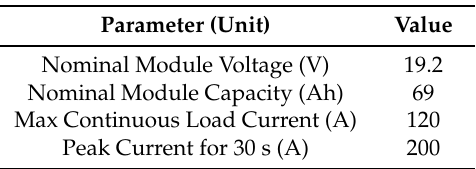
Table 1. Technical data of LiFeMgPO 4 Battery [7].